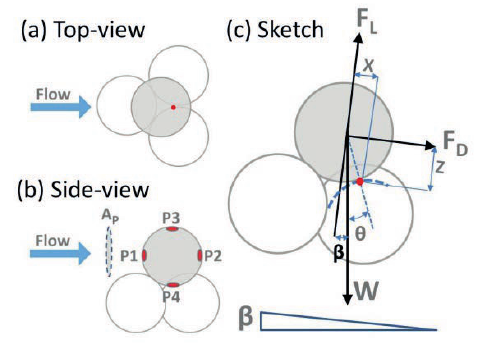
Fig. 2 Sketch of experimental